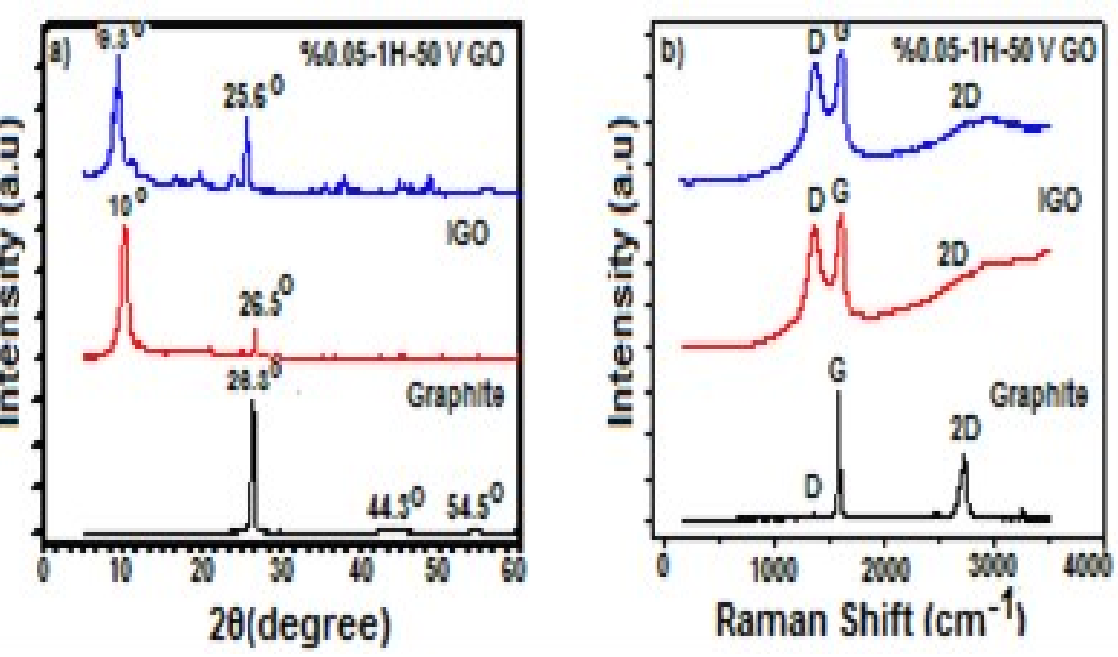
Figure 1 : a) XRD patterns and b) Raman spectrum of graphite rods, IGO and 0.05%-1h-50V GO